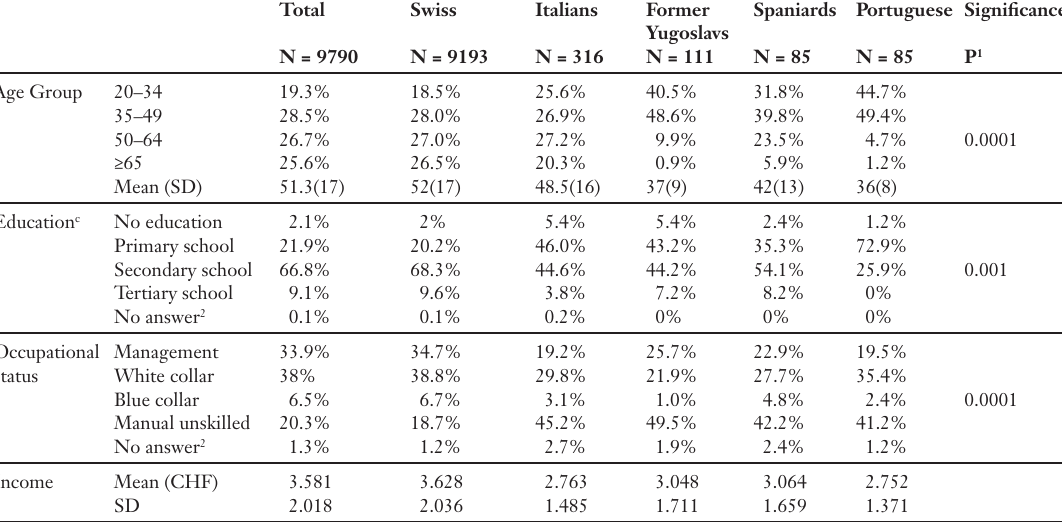
Table 1 Sociodemographic characteristics of analysed subsample from the 2002 SHS, women age ≥20, N =